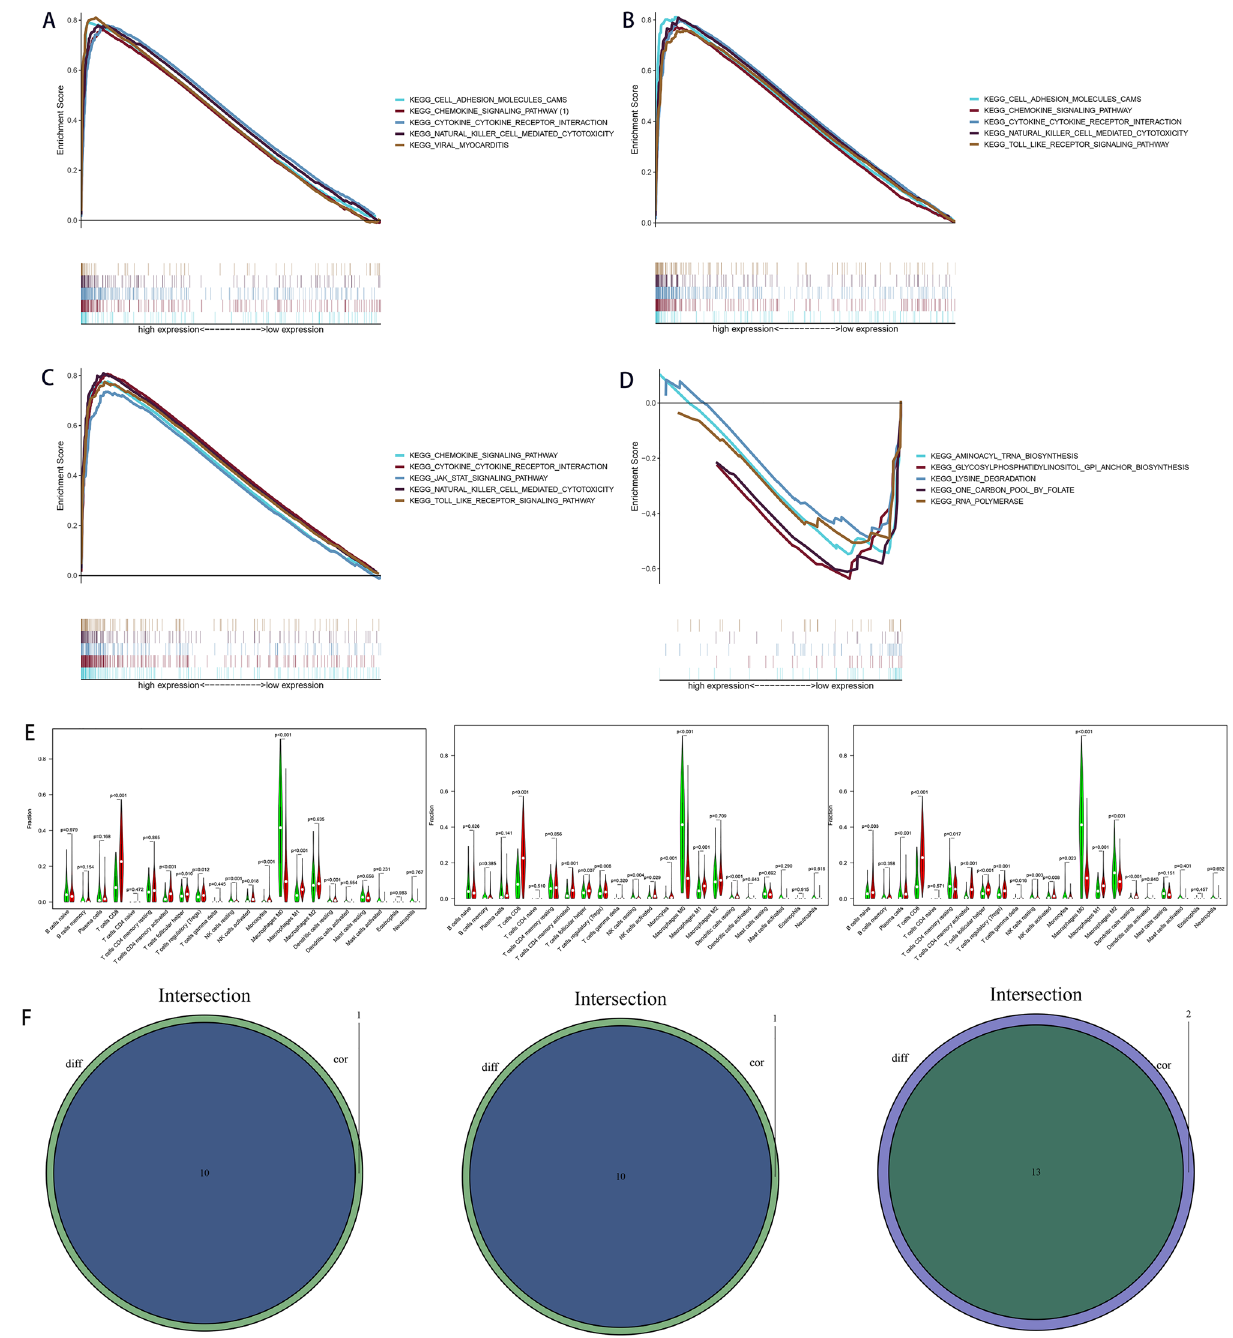
Figure 6. Specific pathways identified by GSEA on the basis of expression levels of GZMB , C1QA , and C1QB and the analyses of associations of C1QA , C1QB and GZMB expressions with TICs of SKCM samples. The top five specific pathways associated with high GZMB expressions ( A ), high C1QA expressions ( B ), high C1QB expressions ( C ) ( P < 0.05). ( D ) The top five specific pathways associated with low GZMB expressions ( P < 0.05). ( E ) Violin plots of the proportions of 22 immune cell types in tumor tissues with low (green) or high (red) expression of C1QA , C1QB and GZMB , compared using the Wilcoxon rank sum test. ( F ) Venn diagram of intersection between variance analyses and correlation analyses showing that the TICs were shared between the analyses. This figure was generated using the GSEA v4.1.0 software and “ggplot2” R